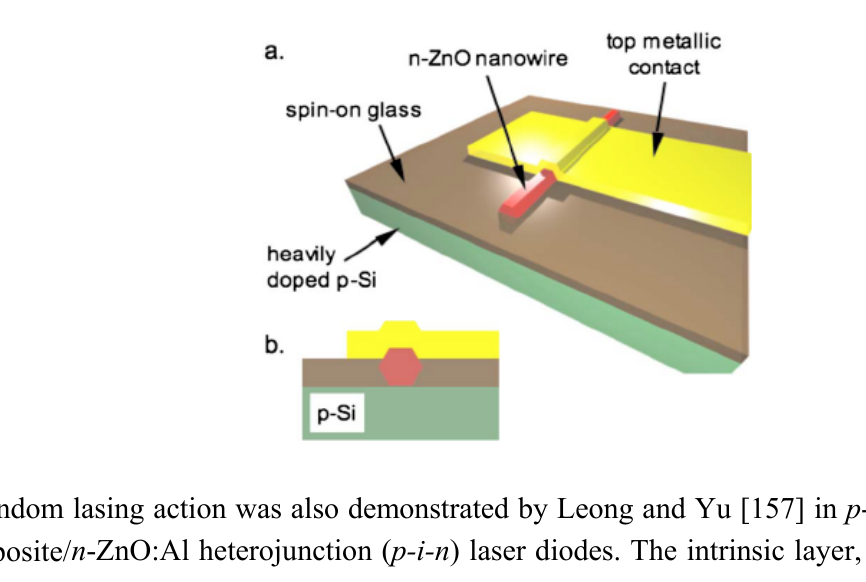
Figure 19. Schematics of the n -ZnO/ p -Si nanowire LEDs. a. Top view, b. cross-sectional view. Reprinted from Ref. [156] with